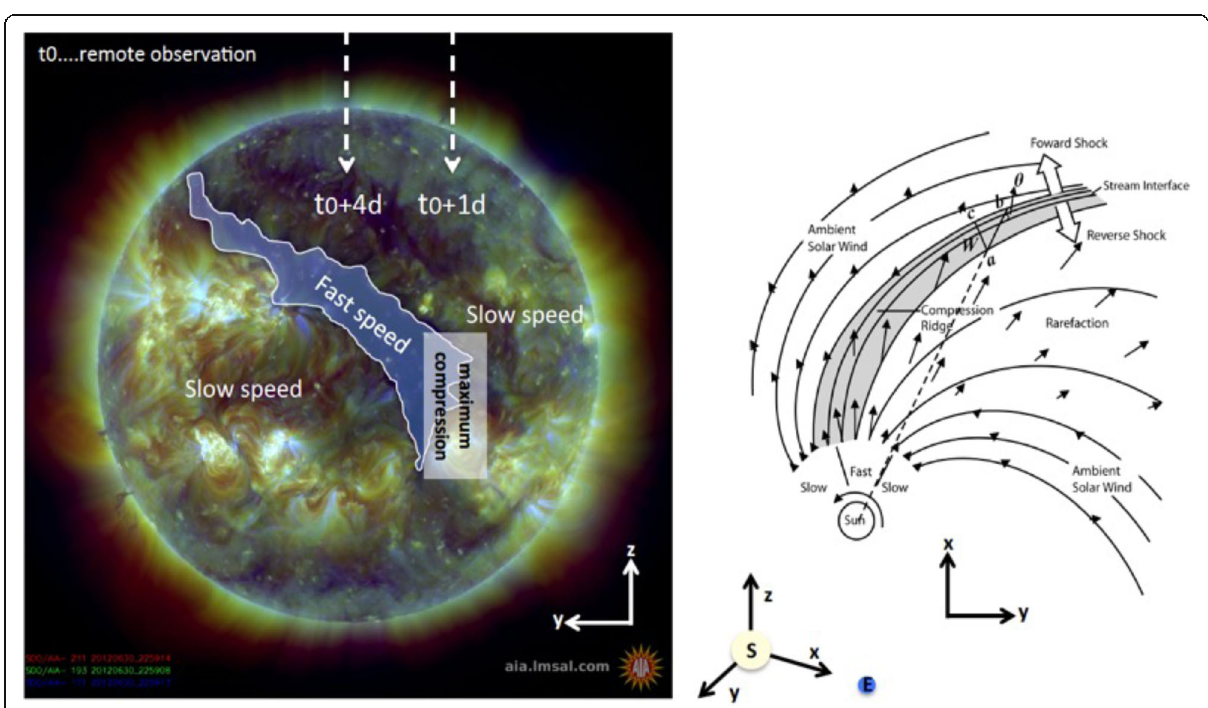
Fig. 31 Left: SDO/AIA composite image of the wavelength channels 211-193-171A from June 30, 2012, showing the reduced density region of a coronal hole (shaded area). At the time t 0 , the central position of the coronal hole is extracted from remote data. At about t 0 + 1 day, the maximum in the density/magnetic field and at about t0 + 4d the maximum in the speed/temperature is observed from in situ data at 1 AU. Right: Cartoon by Pizzo (1978) to illustrate the fundamental processes involved in the 3D dynamics of stream